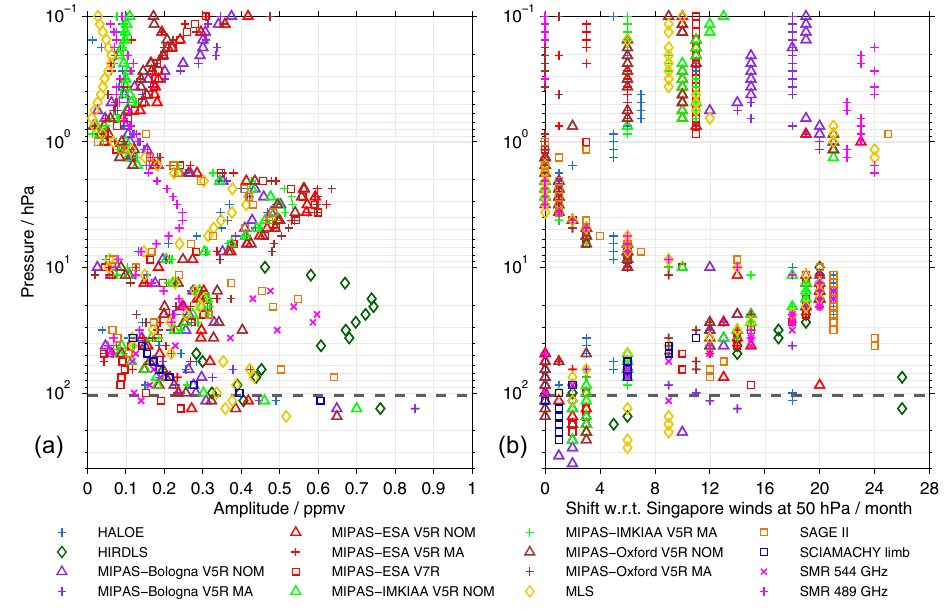
Figure 12. The QBO variation in the tropics (5 ◦ S–5 ◦ N) as derived from the different data